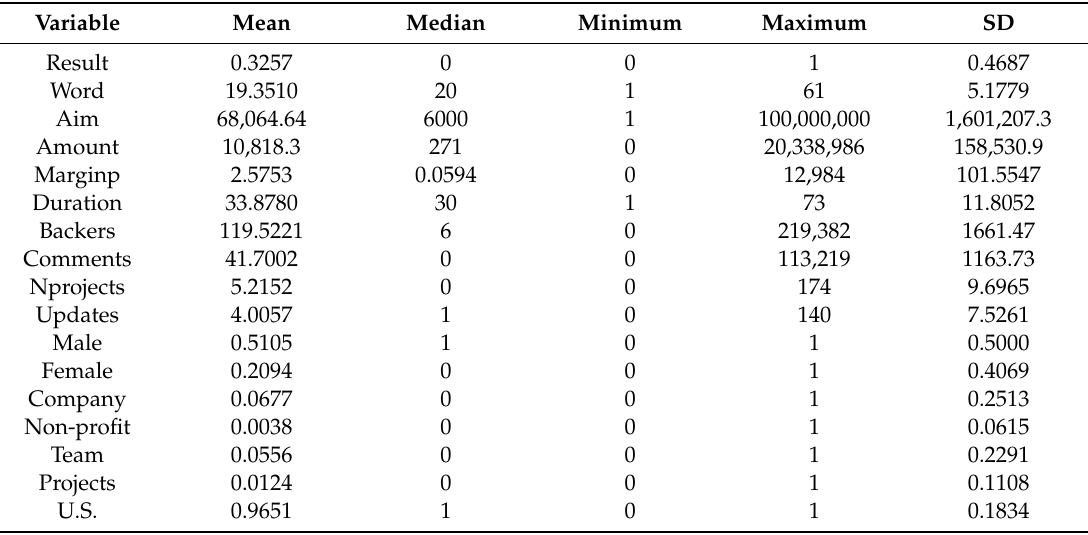
Table 4. Descriptive data of variables. This table provides the descriptive statistics of the di ff erent variables used in this study. Table 3 defines all the